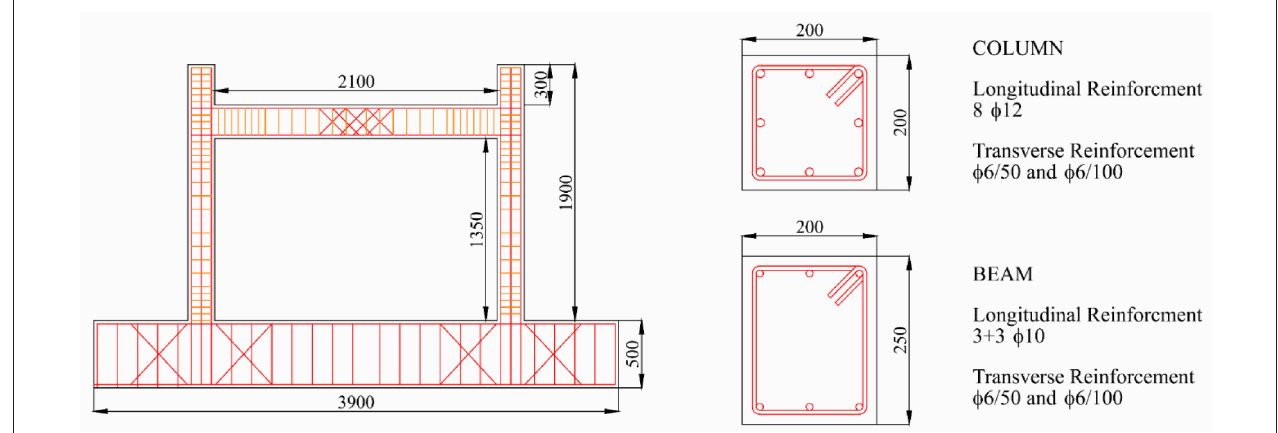
FIGURE 5 | Description of the DF specimen tested by Verderame et al. (2016).